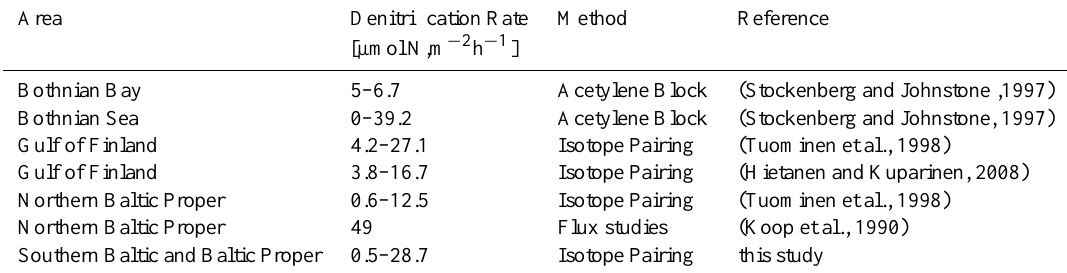
Table 6. Comparison of denitrification rates from Baltic Sea sediments from various